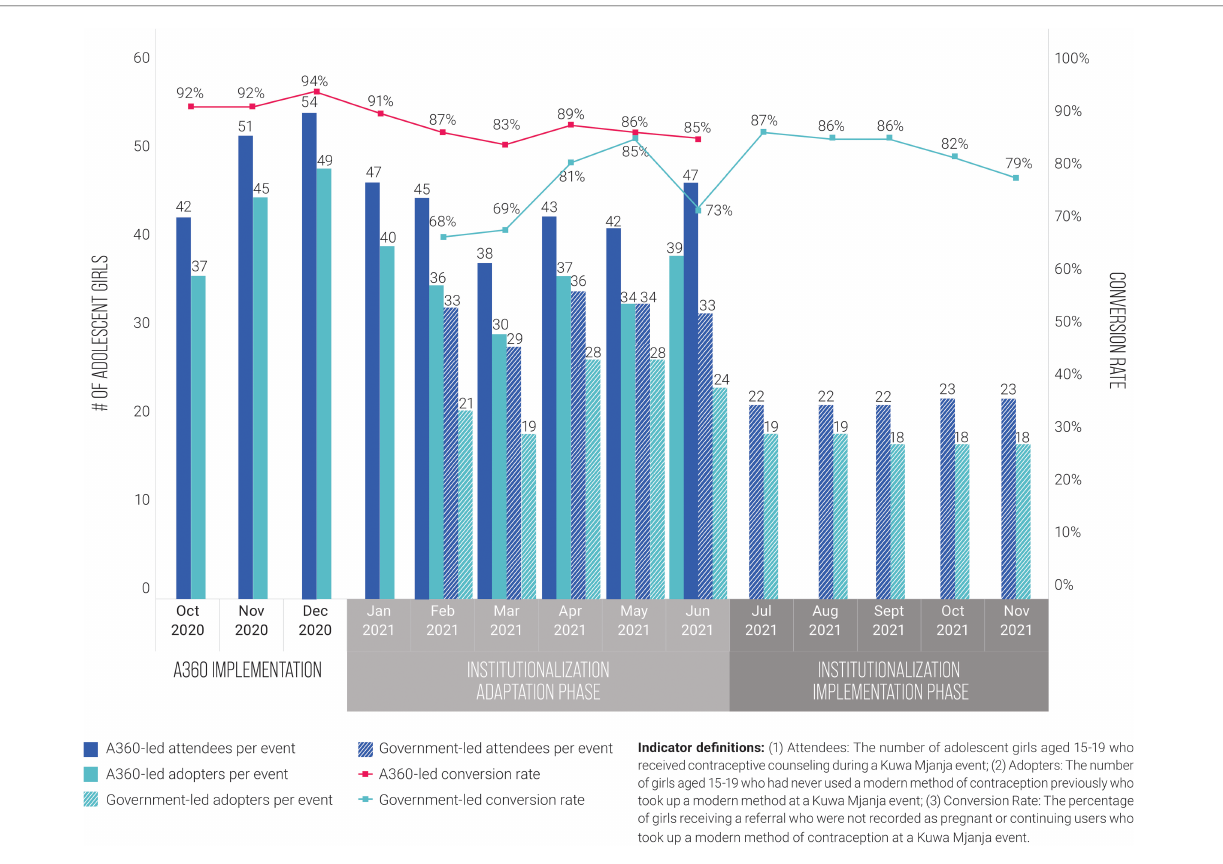
FIGURE 4 Girls reached, contraceptive adopters, and conversion rate per event, A360-led Kuwa Mjanja implementation compared to government-led implementation, October 2020 to November